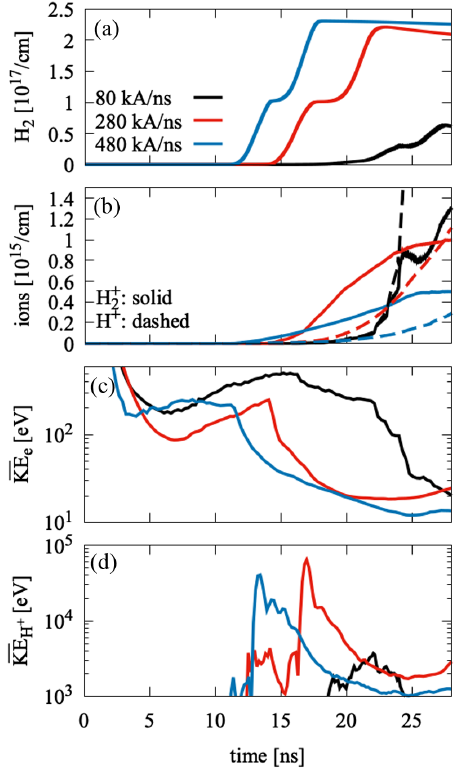
FIG. 8. (a) The average number of neutral H 2 per cm length of transmission line. (b) The average number of H þ 2 and H þ ions per cm. The H þ for 80 kA = ns exceed the scale, reaching 1 . 3 × 10 16 = cm by 28 ns. (c) The average electron kinetic energy of the electrons. (d) The average H þ kinetic energy of the